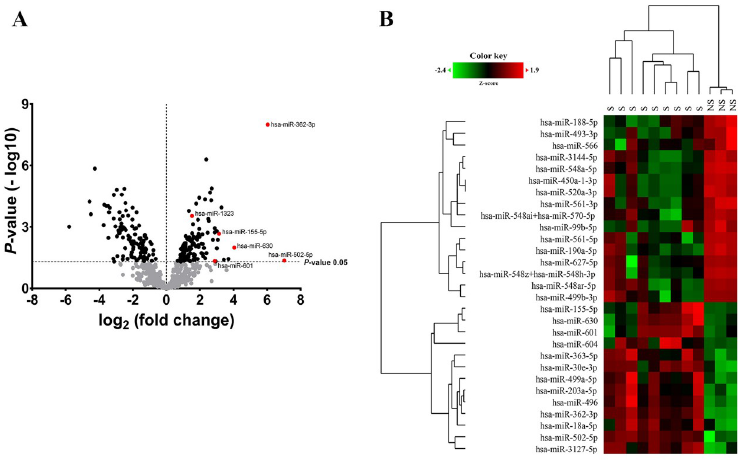
Fig 1. Volcano plot and heatmap for differentially expressed miRNAs between severe and non-severe leptospirosis groups. (A) Volcano plot for differentially expressed miRNAs, showing distribution of significance [-log10(p-value)] vs. fold change [log2(fold change)] for all genes. The miRNAs selected for qRT-PCR validation are highlighted with red dots and gene symbols marked (Fold change � 1.5, p-value < 0.05). The dots in black are significant differentially expressed miRNAs (p � 0.05). (B) Heat map of significant differentially expressed miRNAs. Heatmap shows the signal of 29 miRNAs (p-value < 0.05; log2fold change ± 3).